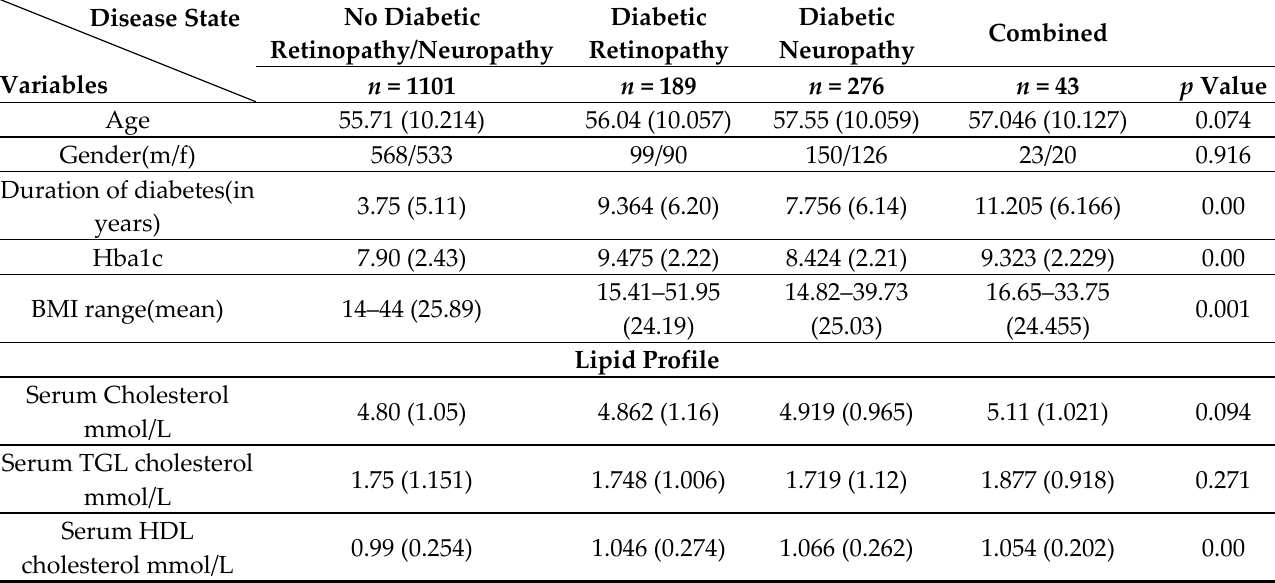
Table 4. Demographics and clinical characteristics of the patients.